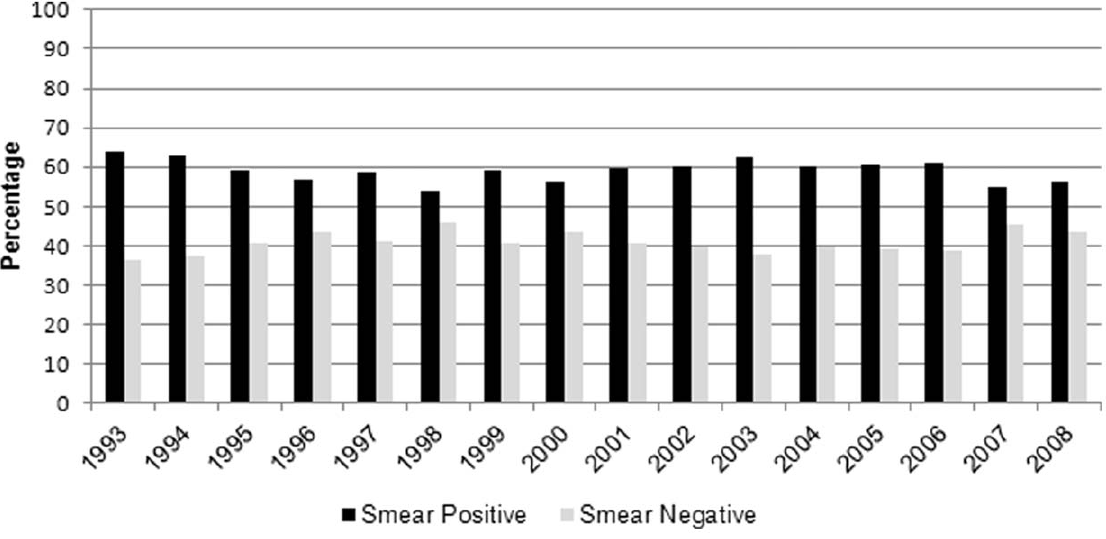
Figure 1. Sputum smear status among patients with HIV and culture-confirmed TB among those with reported sputum smear, United States, 1993–2008. Black bars indicate the percentage of patients with reported sputum smear result who were smear-positive. Gray bars indicate the percentage of patients with who were smear-negative.